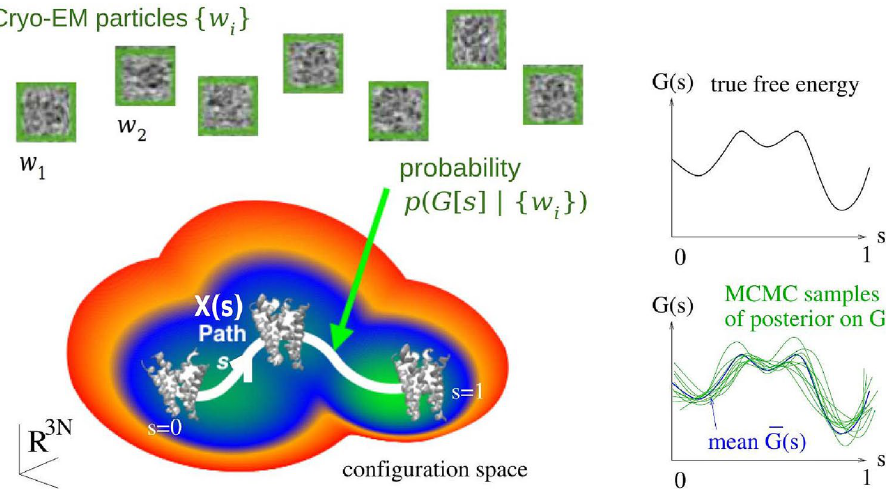
Figure 1. Schematic representation of the path collective variable and Bayesian formalism for cryo-BIFE. The main goal of our methodology is to determine the posterior probability distribution of free-energy profiles G ( s ) over a given configuration space path X ( s ), given a set of noisy cryo-EM particle (projection) images w = { w i } from i = 1, . . . , I . The green graphs on the right show independent samples drawn from this posterior, and the blue curve their mean. The black curve represents the true free-energy profile. Variation between sampled free energy surfaces arises from a detailed Bayesian model of imaging noise. The path 0 ≤ s ≤ 1 is discretized using M